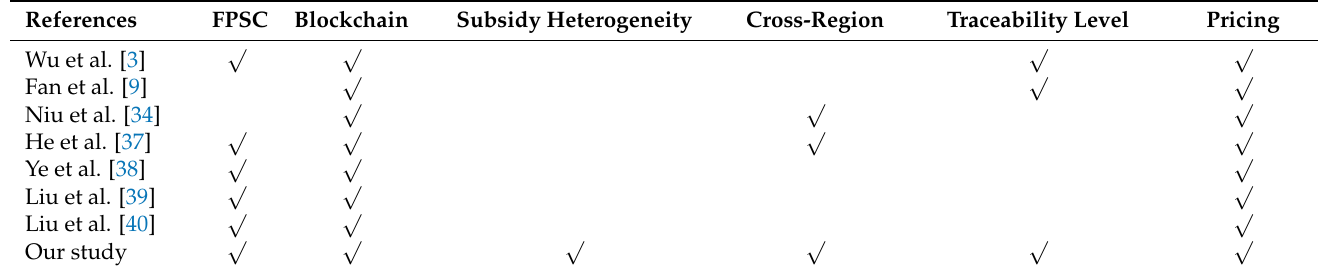
Table 1. The comparison of our study with closely relevant